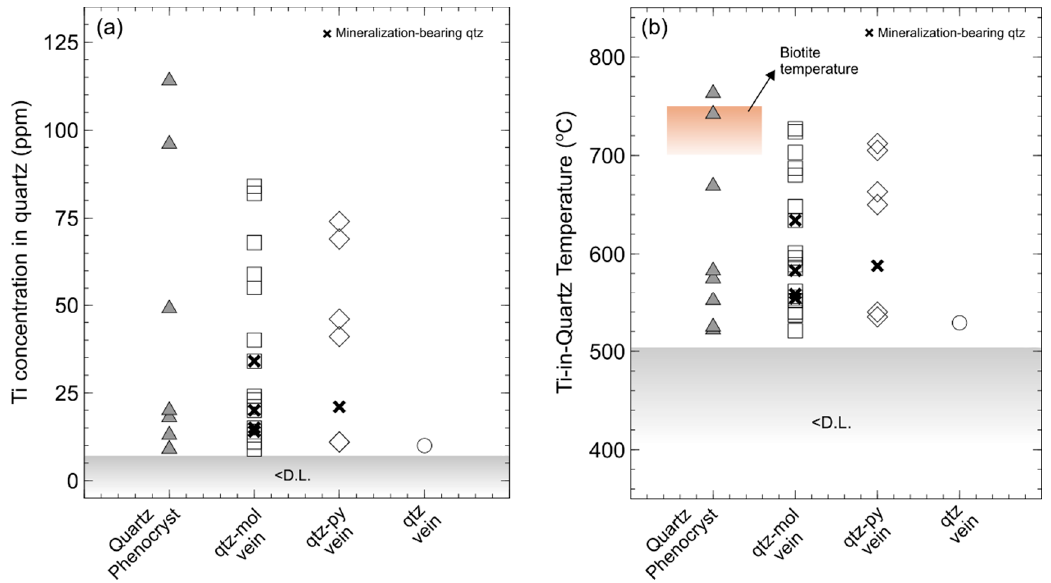
Figure 8. ( a ) Ti concentrations of quartz phenocrysts and vein quartz from the Erdenet deposit. ( b ) Minimum temperature of quartz vein formation calculated using the model of [28]. D.L. = detection limit.